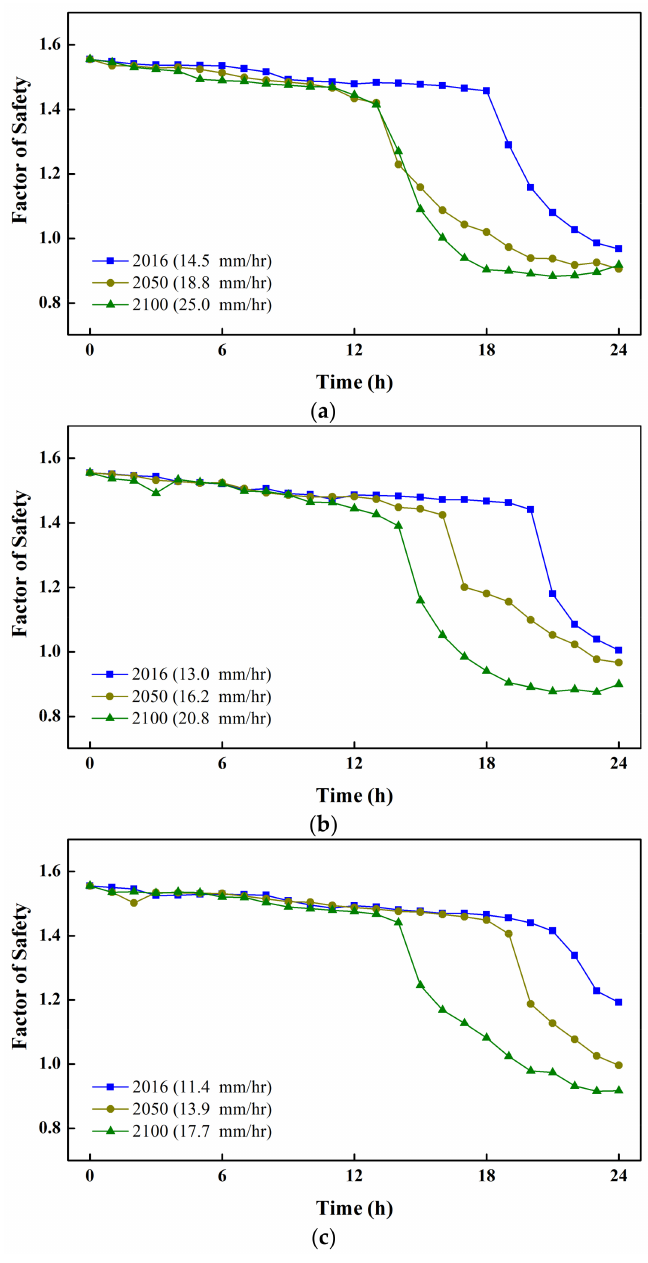
Figure 8. Results of slope stability analysis for the period 2016, 2050 and 2100: ( a ) Da-Dong-Shan rainfall station; ( b ) Ma-To-Shan rainfall station; ( c ) San-Jiao-Nan-Shan rainfall